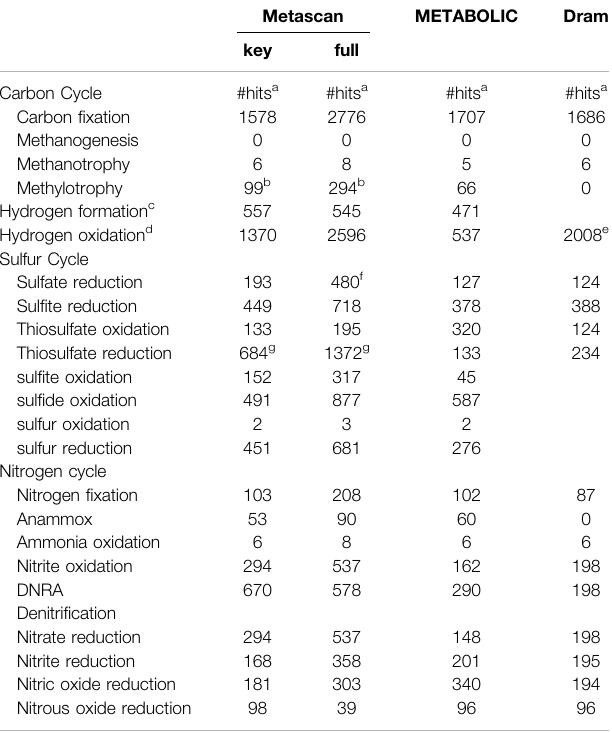
TABLE 8 | Results from Metascan (unbinned), Metabolic (unbinned), and DRAM (unbinned) analyses of the Anantharaman metagenome (2016). Metascan